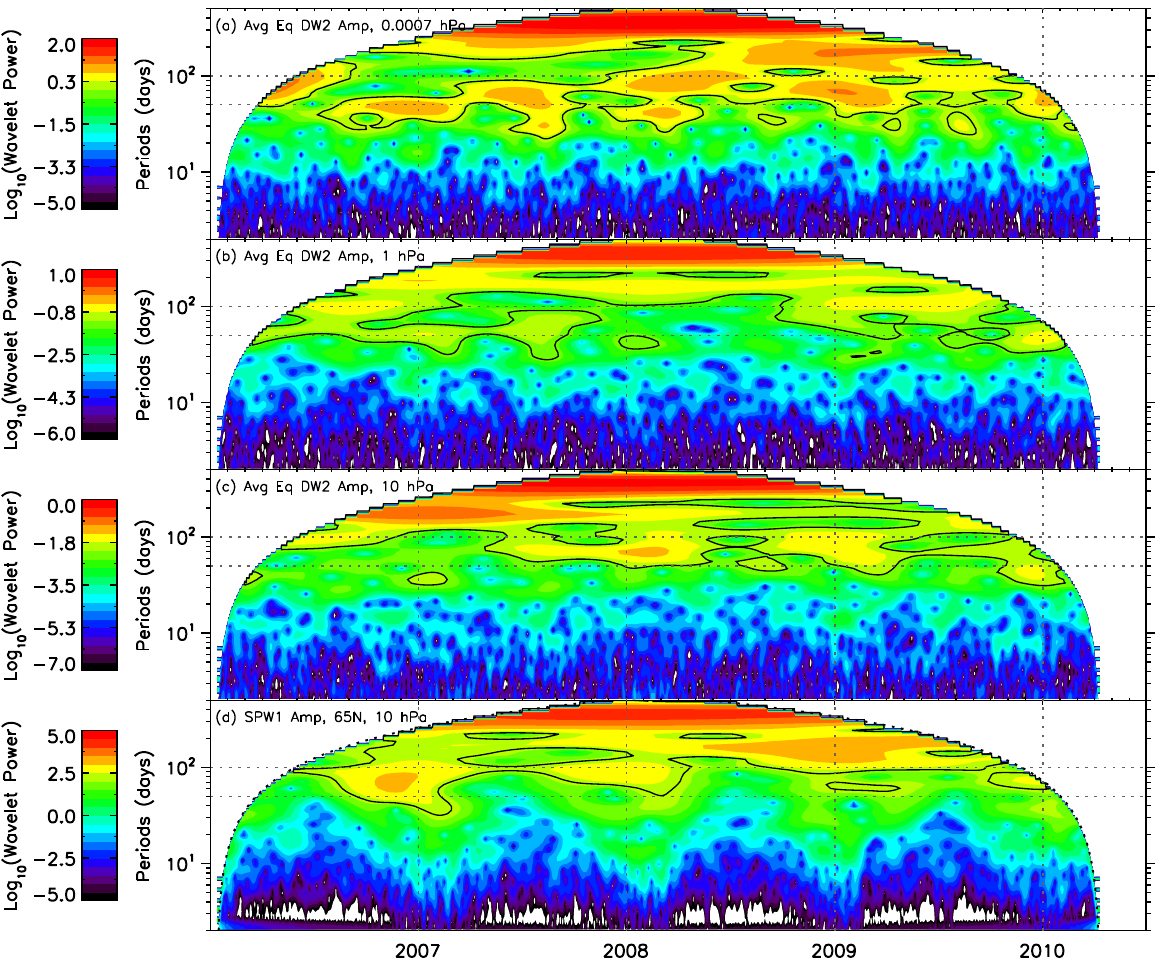
Figure 9. Wavelet power spectrum of average amplitude of DW2 over ± 20 ◦ at ( a ) 0.0007 hPa, ( b ) 1 hPa and ( c ) 10 hPa, ( d ) wavelet power spectrum of SPW1 amplitude over 65 ◦ N at 10 hPa extracted from CMAM30 temperature